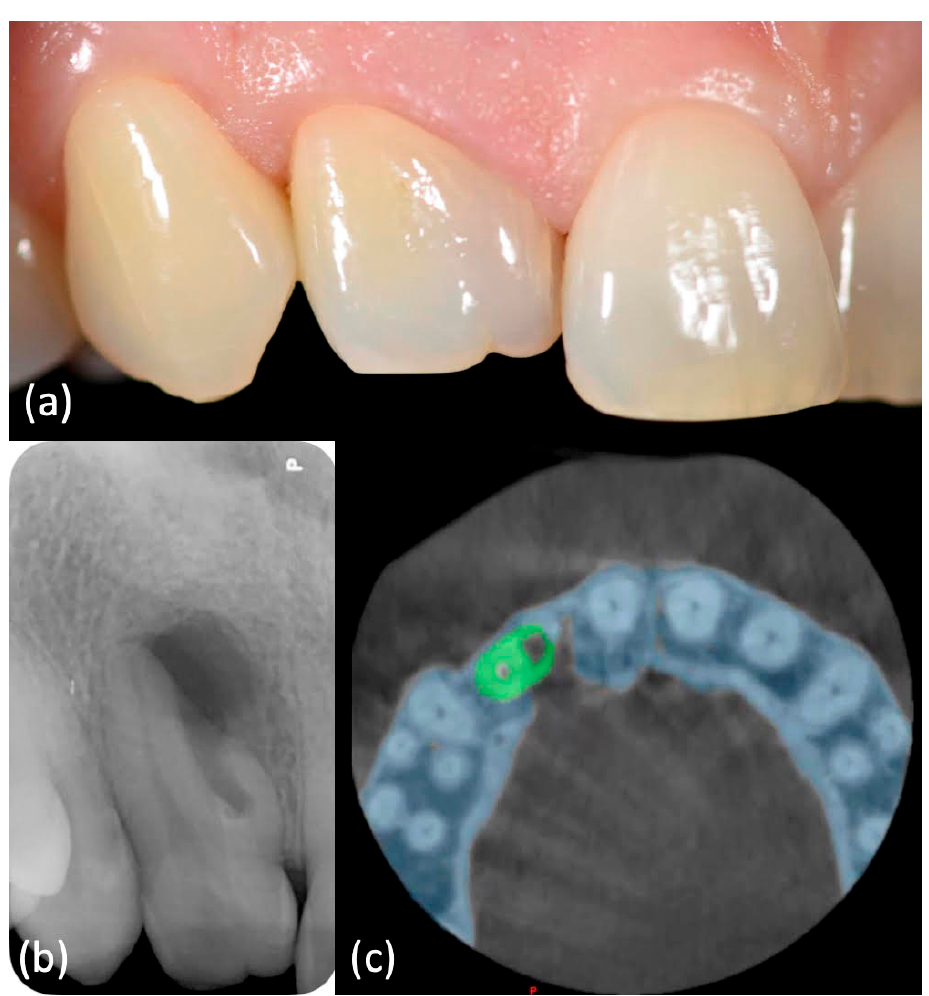
Figure 1. ( a ) Intraoral examination showed a wide crown of element 1.2, typical anatomy of a dens invaginatus. ( b ) Periapical X-ray showed a mesial invagination separated from the main distal canal (dens invaginatus type3a), with an apical radiolucent area. ( c ) CBCT confirmed these